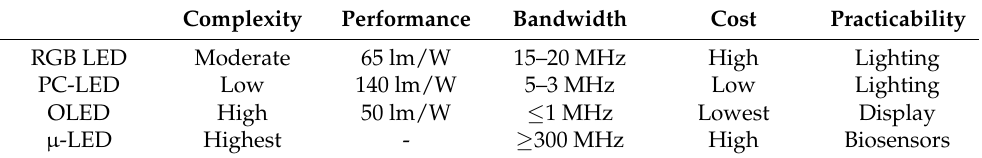
Table 2. The characteristics of LEDs depending on their type, performance, complexity, band and cost. Complexity Performance Bandwidth Cost Practicability RGB LED Moderate 65 lm/W 15–20 MHz High Lighting PC-LED Low 140 lm/W 5–3 MHz Low Lighting OLED High 50 lm/W ≤ 1 MHz Lowest Display µ -LED Highest - ≥ 300 MHz High